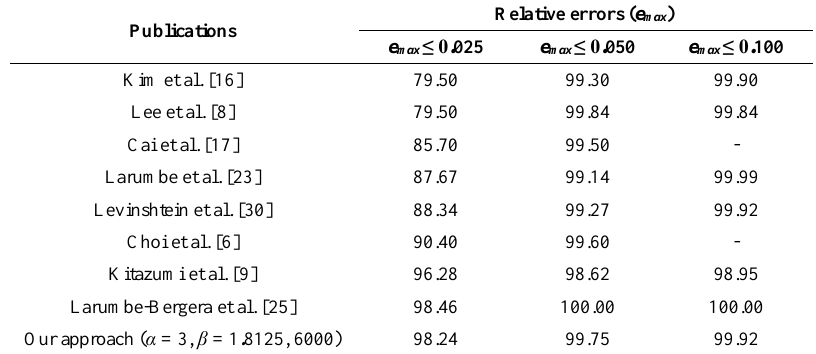
Table 3. Relative errors comparison for pupil center location on the GI4E database for the approaches which produced the relative error 𝒆 𝒎𝒂𝒙 ≤ 0.025 greater than or equal to 79.50%